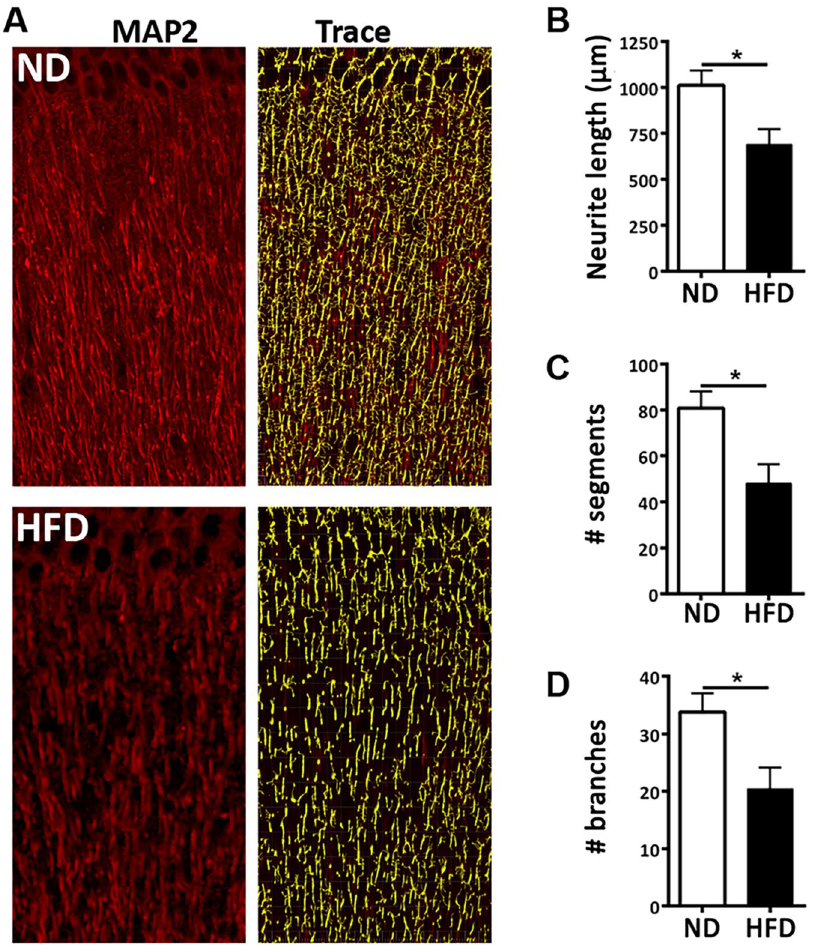
Figure 4. HFD impairs neurite architecture. ( A ) Representative images of MAP2 staining (red) in brain sections of ND and HFD mice with the corresponding tracing (yellow). ( B ) Average neurite length is decreased in brain of HFD compared to ND fed mice. ( C ) Average number of segments is decreased in HFD compared to ND. ( D ) Average number of branches is decreased in HFD compared to ND brains. For F, G and H, length, number of branches and number of segments are normalized on the number of nuclei (DAPI staining). N = 2 males and 3 females/group. Student’s t -test, * p <